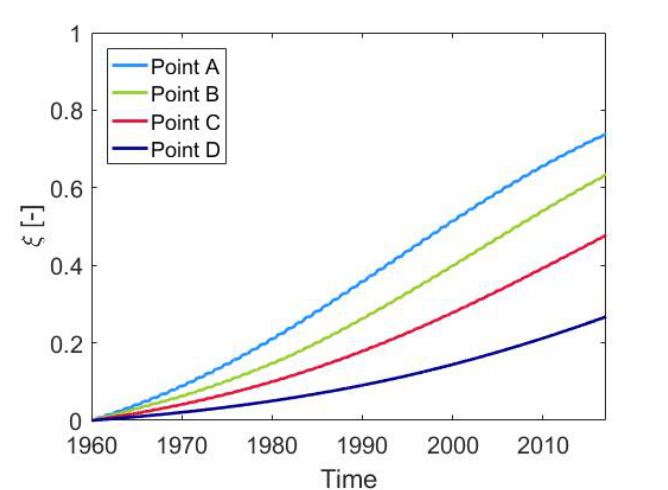
Figure 13. Reaction extent of point A (downstream face), B (upstream face, upper part), C (in the bulk), and D (close to the rock foundation) of the dam (see Figure 9 for point